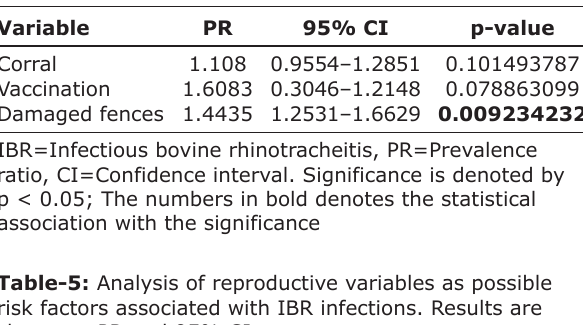
Table-4: Analysis of management practices as possible risk factors associated with IBR infections. Results are shown as PR and 95% CI.